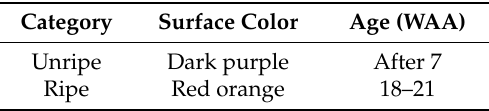
Table 2. Characteristics of the selected samples.